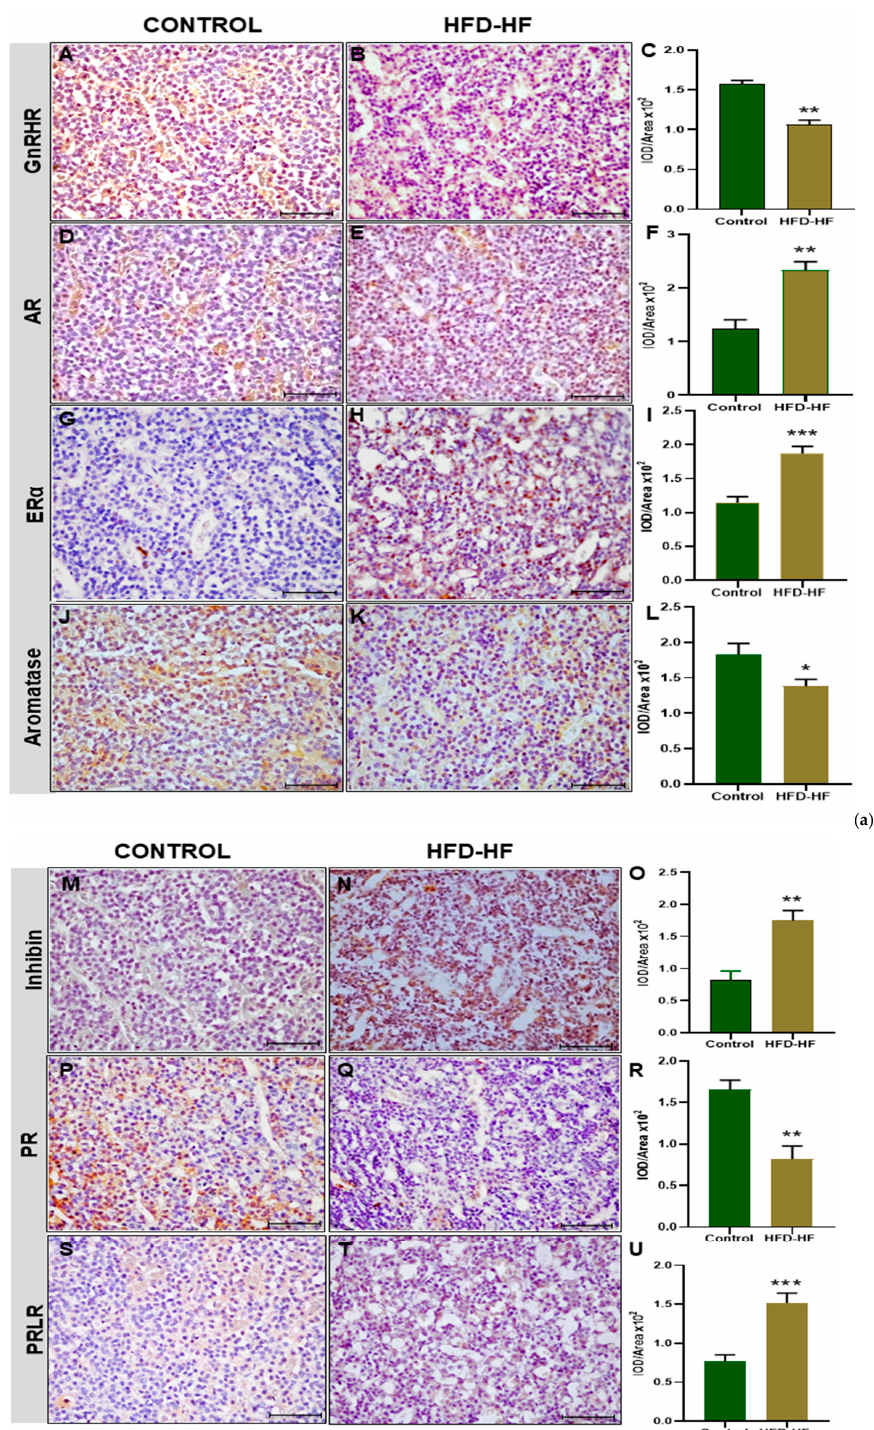
Figure 4. Immunohistochemical localization of gonadotropins and regulatory proteins in the anterior pituitary. ( a ) Immunohistochemical localization of GnRHR ( A – C ), AR ( D – F ), ER α ( G – I ), and P450 aromatase (J–L) protein in the pituitary of adult rats fed on HFD-HF diet ( A – J ) and control rats (B–K). ( b ) Immunohistochemical localization of Inhibin ( M – O ), progesterone receptor (PR) ( P - R ), and prolactin receptor (PRLR) ( S – U ) protein in the pituitary of adult rats subjected to the HFD-HF diet and control rats. Each bar is the mean ± SEM of the observations from six animals from each group. The (*, **, ***) signs noted on the bars represent statistically significant differences (* p ≤ 0.05, ** p ≤ 0.01, *** p ≤ 0.0001 vs. control group) between the respective means. [Scale bar = 100 µm].